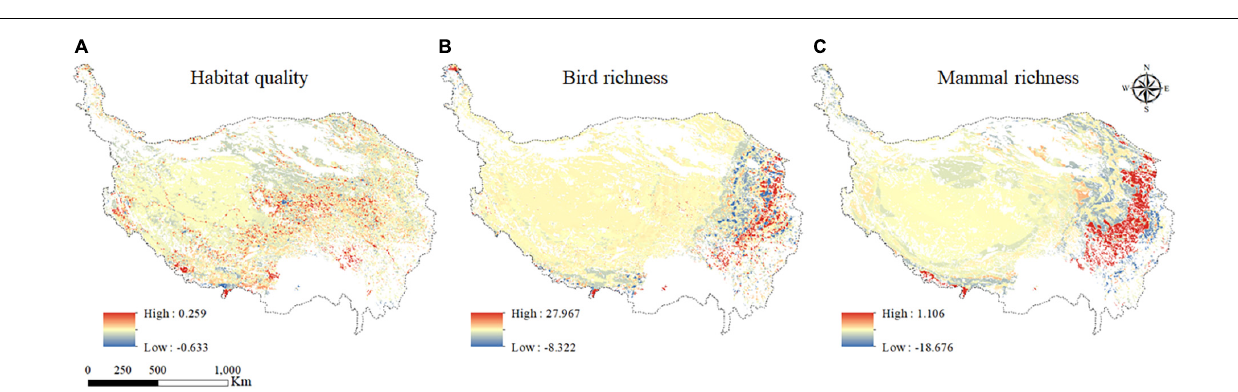
FIGURE 7 | Regression coefficient distribution of grazing activities of habitat quality (A) ; bird species richness (B) ; and mammal richness (C)